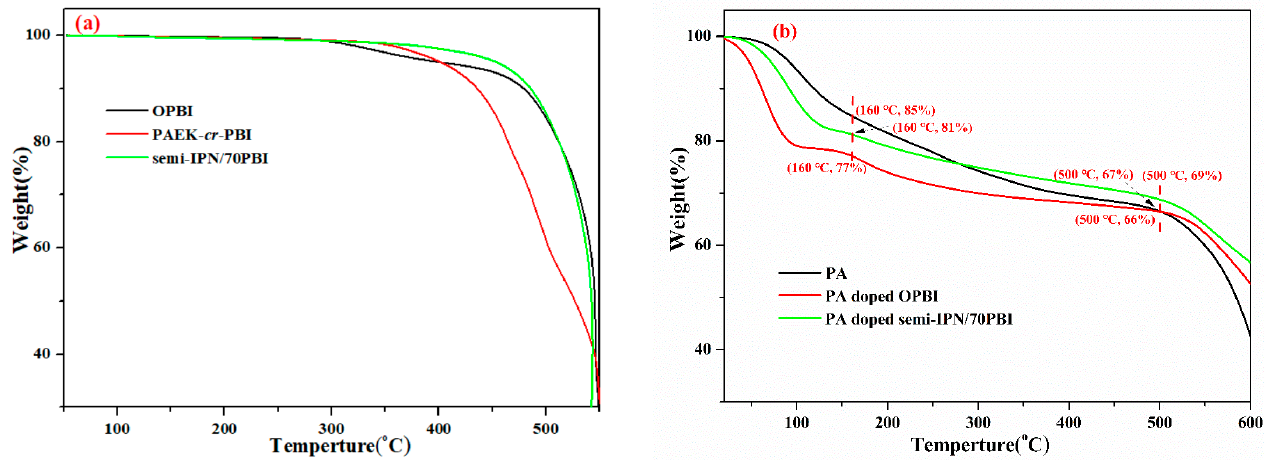
Figure 4. TGA curves of ( a ) PA undoped, and ( b ) PA doped OPBI, PAEK- cr -PBI, and semi- membranes under O 2 flow at a heating rate of 10 ◦ C min − 1 Table 1. 5% weight loss temperature for dry membrane.